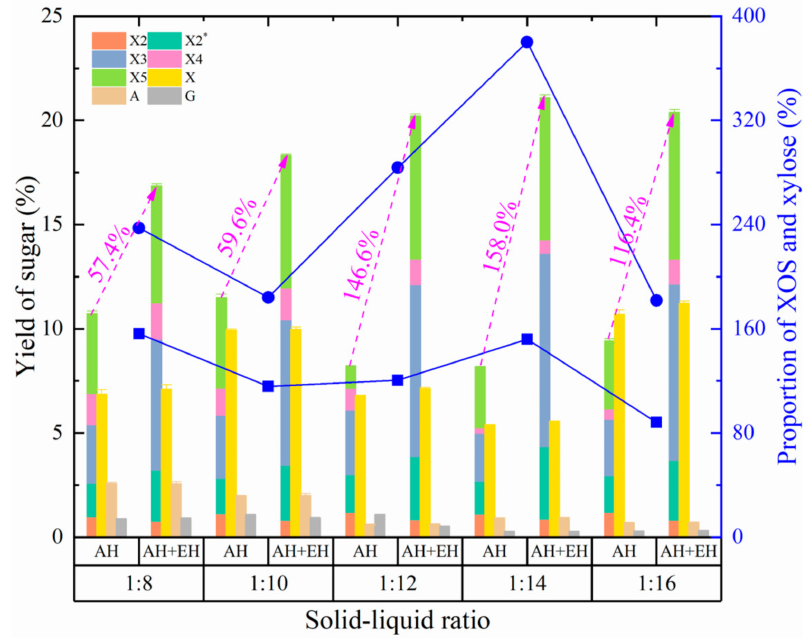
Figure 4. Effects of autohydrolysis pretreatments on sugar yield and the proportion of XOS and xylose at different solid-liquid ratio conditions. AH, autohydrolysis-only treatment, no enzymatic hydrolysis treatment; AH + EH, autohydrolysis plus enzymatic hydrolysis treatment. Squares and solid line, the proportion of XOS and xylose for the autohydrolysis only treatment; circles and solid line, the proportion of XOS and xylose for the autohydrolysis plus enzymatic hydrolysis treatment. The magenta text is the percentage increase in the yield of XOS after autohydrolysis plus enzymatic hydrolysis treatment compared with that of the autohydrolysis-only treatment at different solid-liquid ratios. X2, xylobiose; X2*, an oligosaccharide with a degree of polymerization between X2 and X3; X3, xylotriose; X4, xylotetraose; X5, xylopentaose; X, xylose; A, arabinose; G,